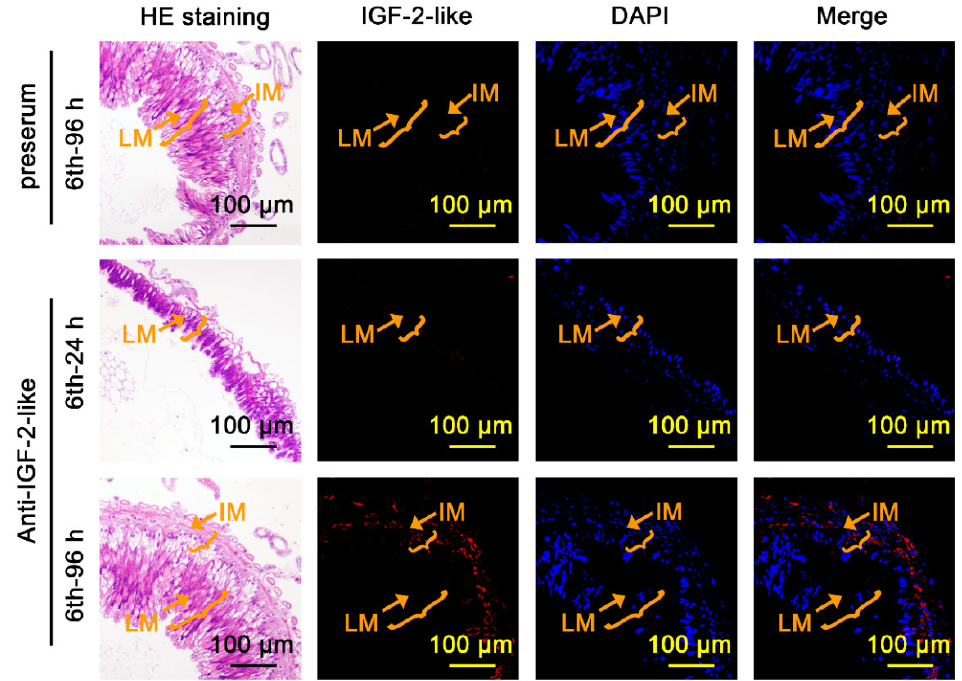
Figure 3. IGF-2-like was localized in the imaginal midgut at the metamorphic stage. HE staining showing the midgut structure after immunofluorescence staining. LM: larval midgut; IM: imaginal midgut; red fluorescence: IGF-2-like detected by anti-IGF-2-like rabbit polyclonal antibodies and Cy3-conjugated goat anti-rabbit IgG (H+L) antibodies; blue fluorescence: DAPI. Preserum was used as the negative control. Merge: IGF-2-like and DAPI.